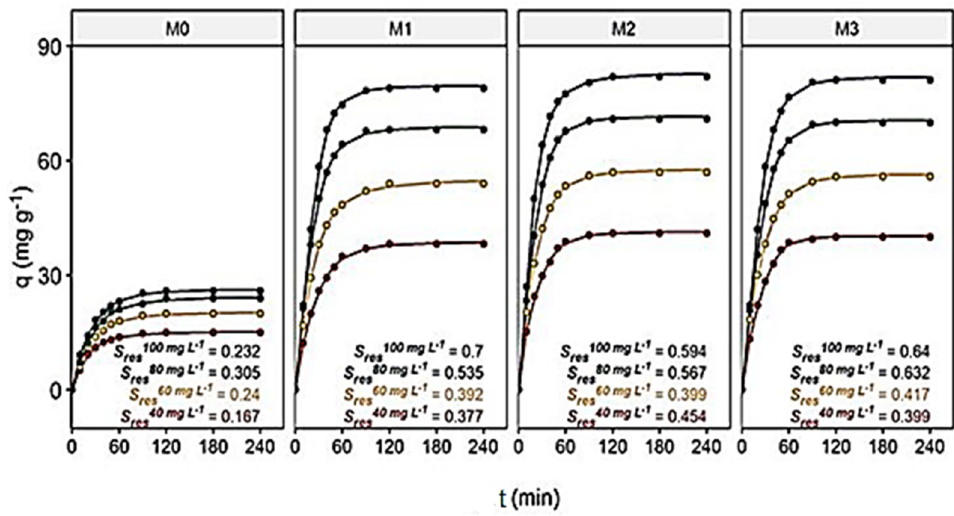
Figure 7. The contact time’s effect on dye adsorption capacity ( q , mg g − 1 ) as a function of the initial dye concentration ( C , mg L − 1 ).